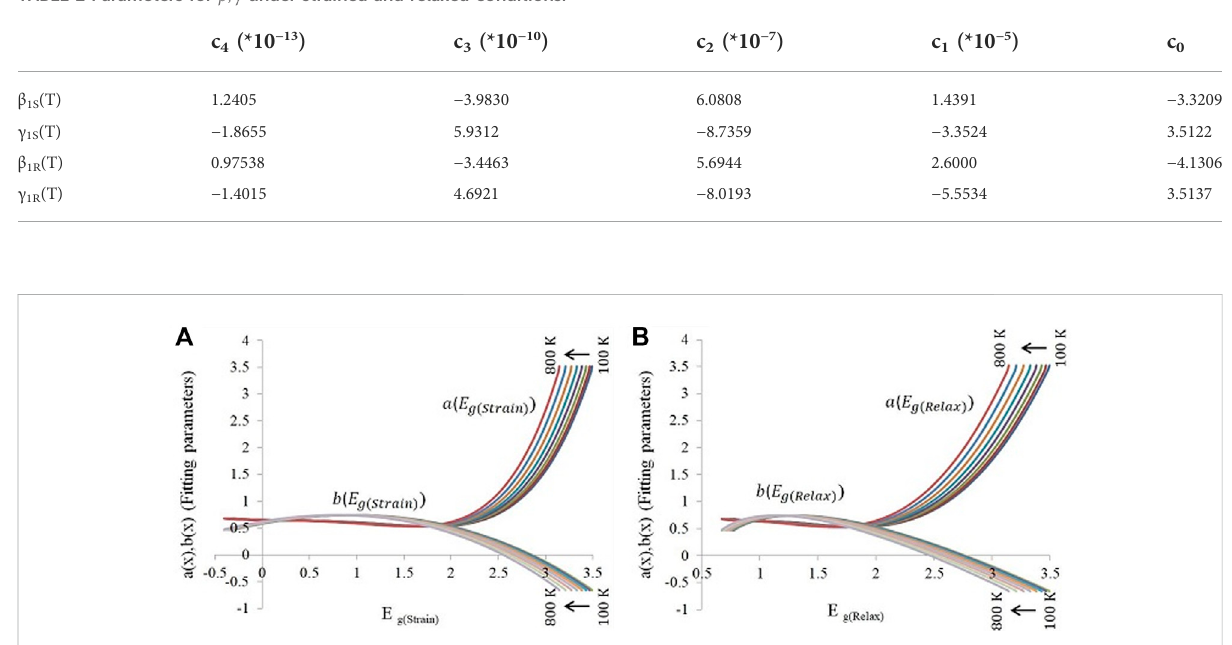
TABLE 2 Parameters for β , γ under strained and relaxed conditions.